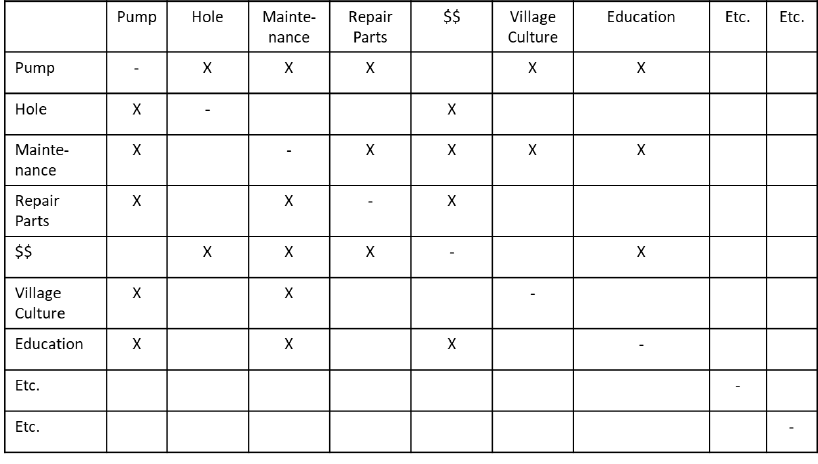
Fig. 31. System interrelationship matrix for